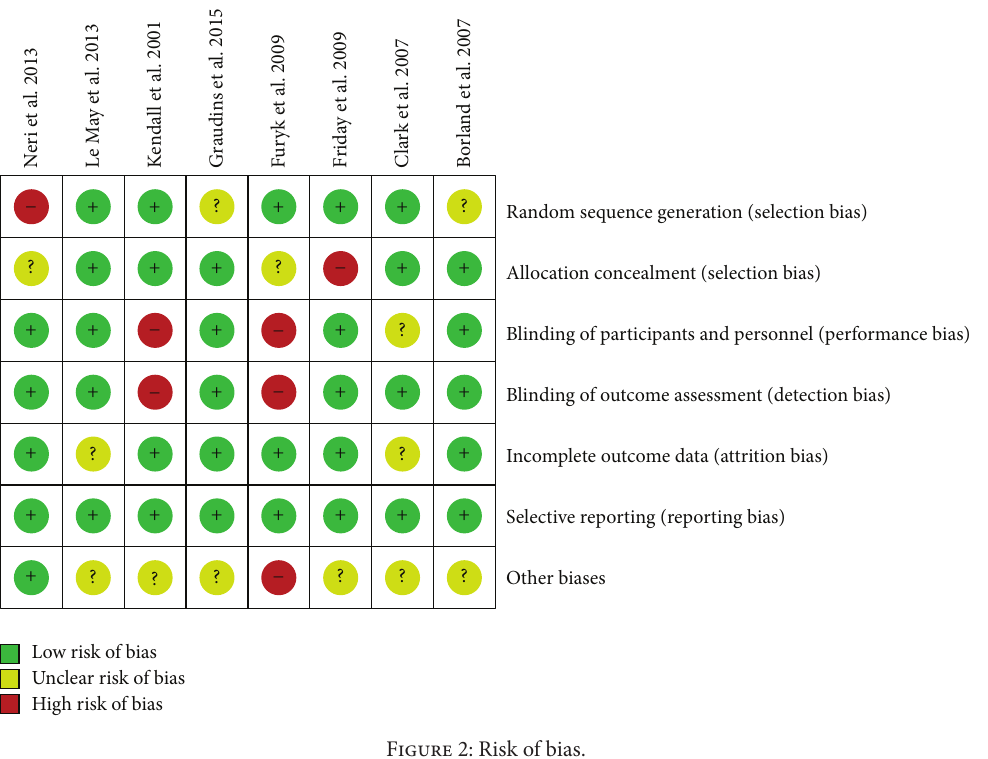
Figure 2: Risk of